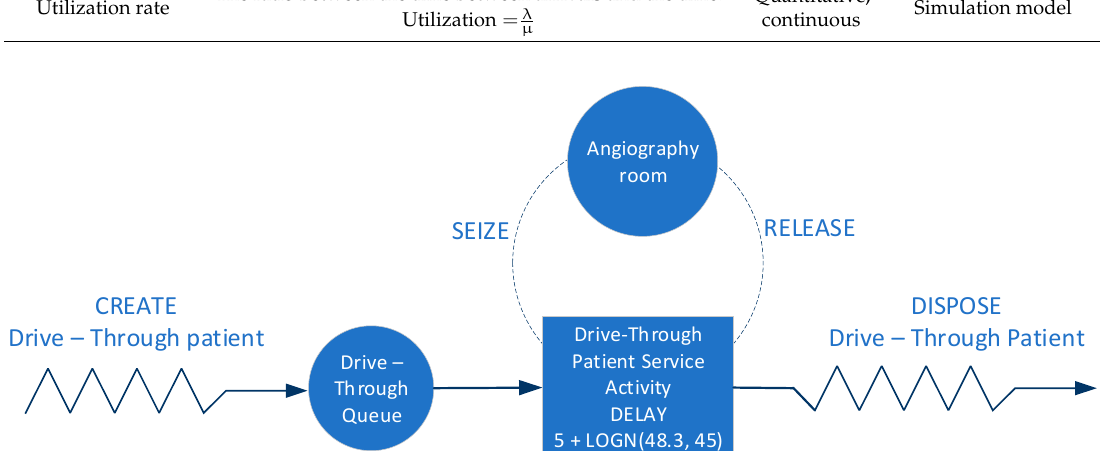
Figure 2. Simulation model made for the angiography room.